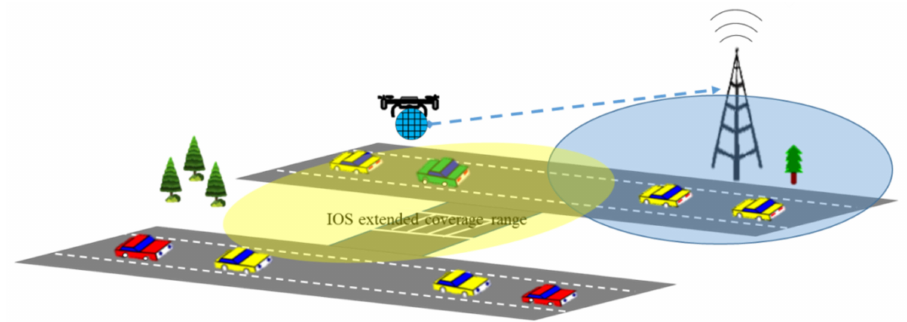
Figure 10. IRS-assisted UAV communication for extended